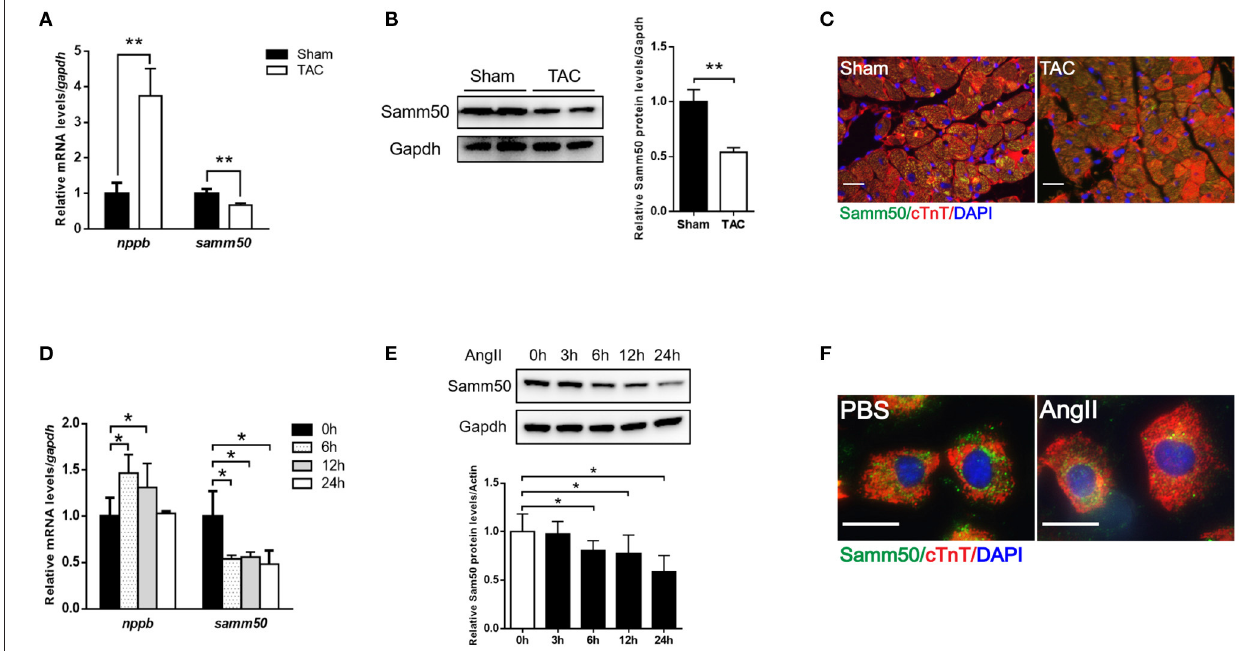
FIGURE 1 | Samm50 is decreased in cardiomyocytes and ventricular tissues. (A) Quantification analysis of samm50 and nppb expression in hearts of Sham and TAC mouse. (B) Representative western bolts (WBs) images and statistical results of samm50 expression in cardiac tissues. (C) Immunofluorescence staining of samm50 in mouse ventricular tissues of Sham and TAC group. Scale bars, 20 µ m. n = 5 mice in each group. (D,E) Quantification (left) and WBs (right) of samm50 expression in mouse neonatal cardiomyocytes treated with Ang II (10 − 6 M) for the indicated time points. (F) Immunofluorescence staining of endogenous samm50 in mouse neonatal cardiomyocytes treated with PBS or Ang II. Scale bars, 20 µ m. n = 3 independent experiments. ** P < 0.01 compared with Sham or PBS group; and * P < 0.05 compared with Sham or PBS group. All data are presented as mean ±